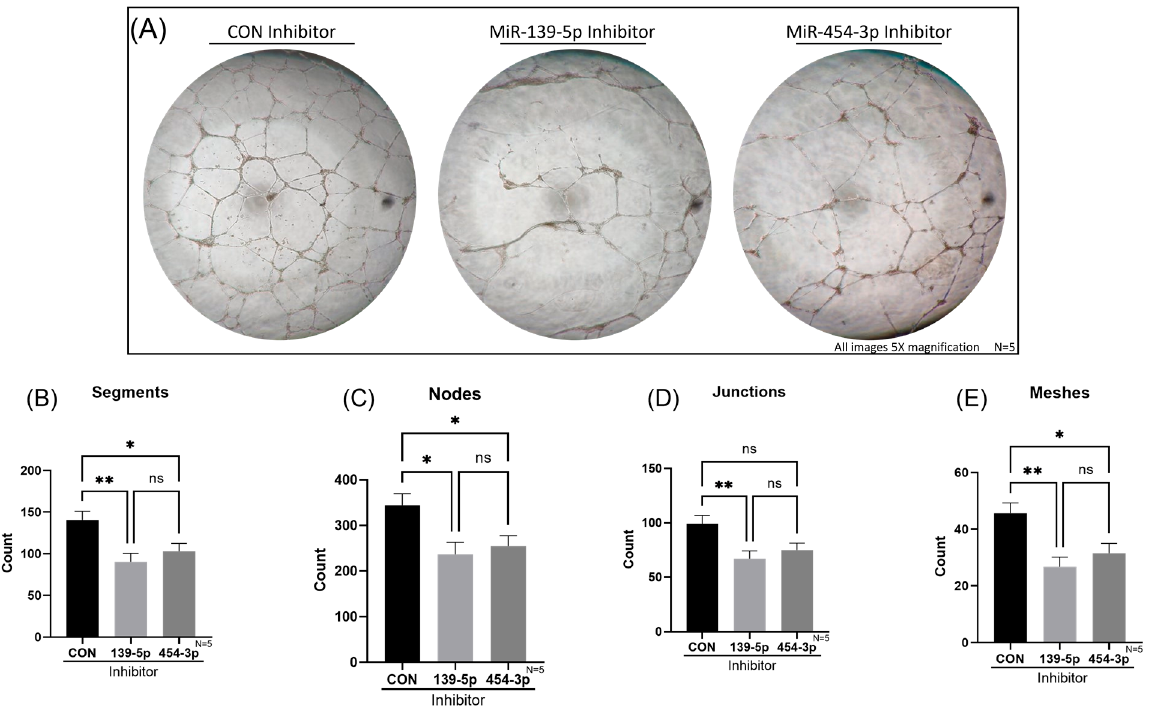
Figure 7. In vitro tube formation assay of HUVECs with miR-139-5p or miR-454-3p inhibition compared with that of negative controls (CON). ( A ) Images taken at 16 h of negative control, miR-139-5p inhibition and miR-454-3p inhibition HUVEC tube formation (5 × magnification). ( B , C , E ) Significantly lower counts of segments, nodes and meshes were detected for HUVECs with miR-139-5p or miR-454-3p inhibition compared with those in negative controls. ( D ) Significantly lower counts of junctions were found for the inhibition of miR-139-5p, while the inhibition of miR-454-3p returned lower counts of junctions, but it was not statistically significant (N = 5). ns: not significant, * p < 0.05, ** p < 0.01.